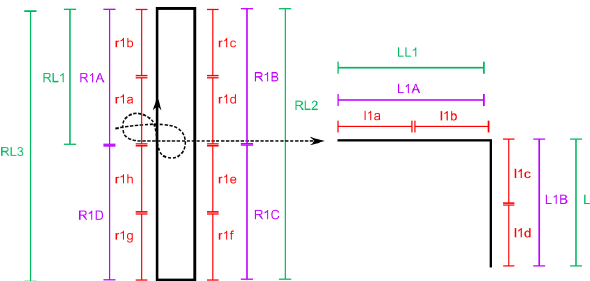
Figure 12. Schematic view of the segmentation of stabilized legs into segments of equal duration and length: 30km, 5min long seg- ments (“short legs”, in red) and 60km, 10min long segments (“long legs”, in purple). Also reported are the “longest legs” (in green), which are the longest stabilized segments in one